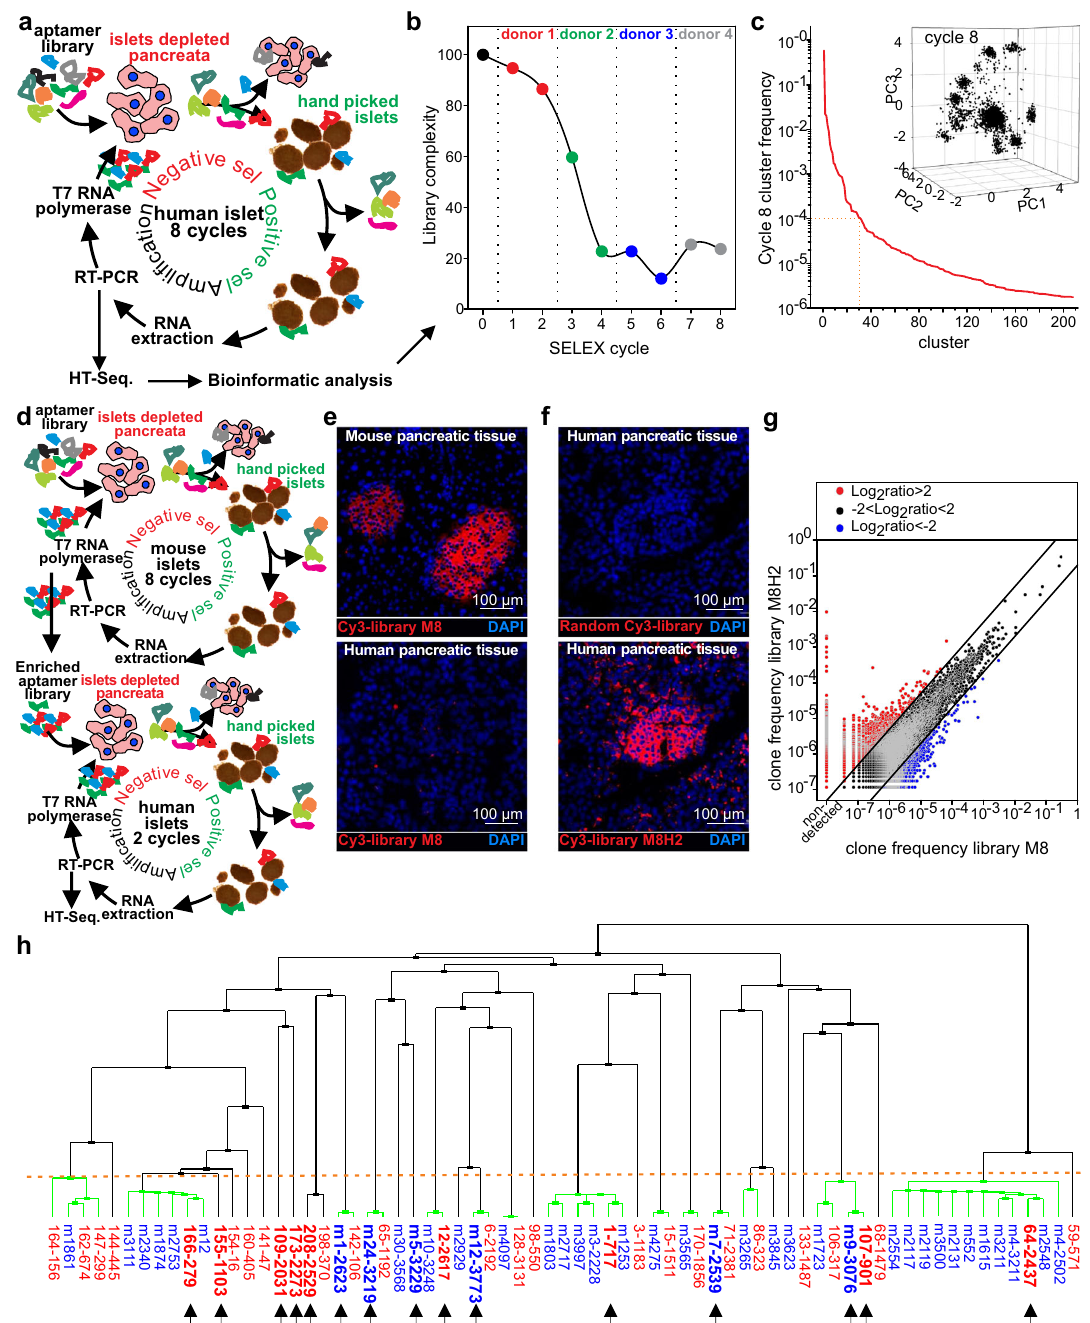
Fig. 1 Cluster-cell SELEX and Toggle SELEX allowed the convergent selection of polyclonal aptamers against human islets. a Schematic diagram of HT Cluster-cell SELEX. A random library of ~10 14 random aptamers was negative and positive selected against islet-depleted exocrine cells and islets from cadaveric donors. Aptamers were then recovered, ampli fi ed, and used for the following selection cycle. Pancreatic specimens from four cadaveric donors were used for the eight selection cycles. b Library complexity decreased during SELEX. Sampled cDNA from the different cycles underwent Illumina-based HT-sequencing, and data were analyzed for aptamer frequency, library complexity, and families identi fi cation. c Frequency of the clusters identi fi ed by Clustal Ω from cycle 8 library and the sum of the frequencies of aptamers from each of the 208 identi fi ed families were plotted. The insert shows the principal component analysis of the 5000 most frequent sequences. d Schematic diagram of HT-Toggle SELEX. Eight cycles (M1 – M8) of selection were performed using acinar cells and islets isolated from BALB/c mice. Two additional cycles of selection (M8H1 and M8H2) were then performed using acinar cells and islets from one cadaveric donor. cDNA library from cycle M8 and M8H2 underwent HT-sequencing. e Mouse and human pancreatic specimens were stained with 1 μ g of cy3-labeled libraries from cycle M8. f Human pancreatic tissues were stained with cy3-library from cycle 0 (irrelevant control) or M8H2. g Frequency of aptamers from cycle M8 and cycle M8H2. h Neighbor-joining tree of selected aptamers from the two selection strategies. Thirty- one aptamers, chosen from the “ cluster-cell ” SELEX (red), and 39 aptamers, from the toggle SELEX (blue), were aligned. Branches that contain aptamers from both selections are highlighted in green. Fifteen aptamers (arrows) representing the main branches were selected for empirical testing. Source data are provided as a Source Data fi